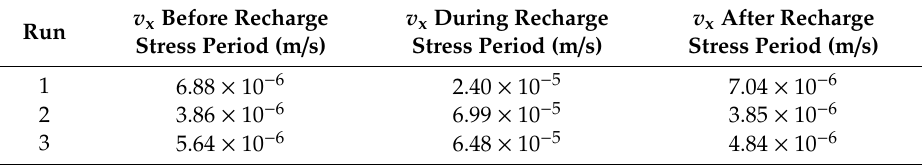
Table 6. Average groundwater velocity ( v x ) measurements of the numerical model simulations before, during, and after the recharge stress event.